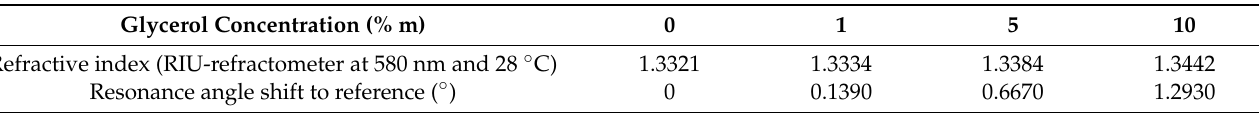
Table A1. Measures determining the chip sensitivity of a 46 nm thick Cu layer on glass, passivated with 2 nm Al 2 O 3 . The refractive index of the different solutions used was measured with a refrac- tometer at 580 nm. We assume the ∆ n remains identical at the SPR wavelength. A linear fitting of the data gives a sensitivity of 105.9 ◦ RIU − 1